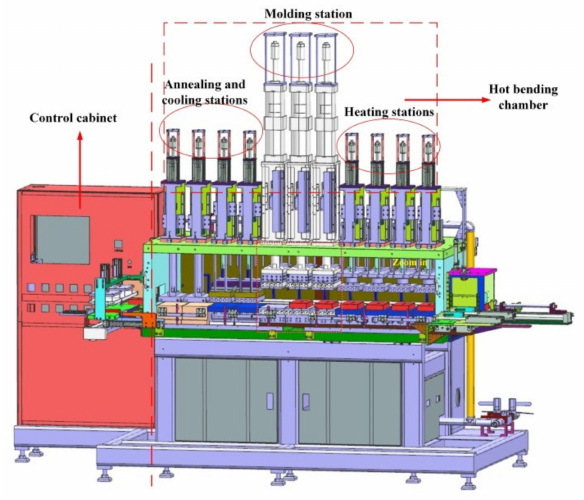
Figure 2. Schematic diagram of multi station bending process (heating stations, molding stations and annealing and cooling